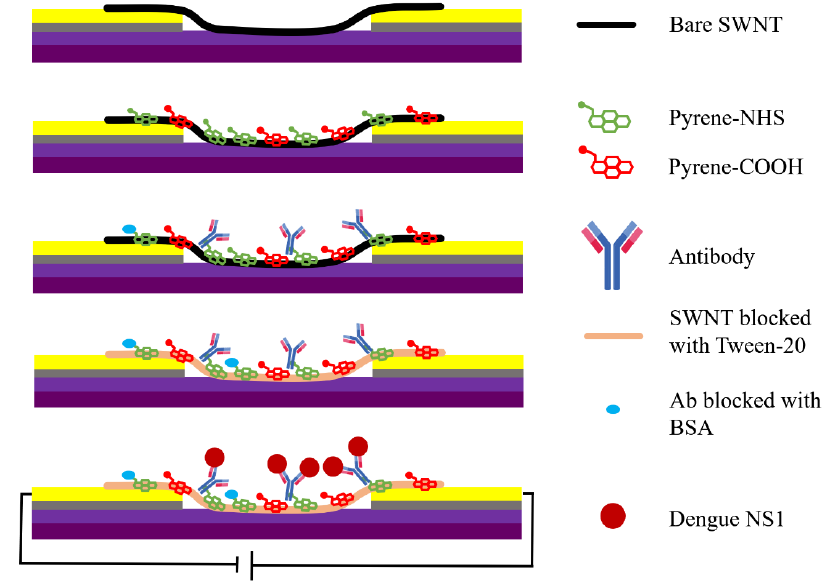
Figure 1. Schematic of functionalization of single-walled nanotubes (SWNTs) networks with anti-non-structural protein 1 (NS1) antibody.